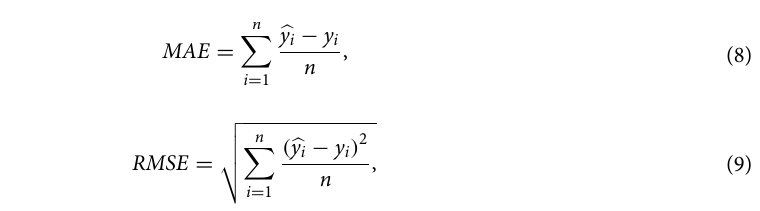
Figure 4. MAE, RMSE and NMSE for respiratory motion prediction of all 76 patients as a function of breathing speed (BPM), with 5th order polynomial trendlines (dashed lines). (Testing conditions: N = 14 , N ′ = 12 , k tr = 600